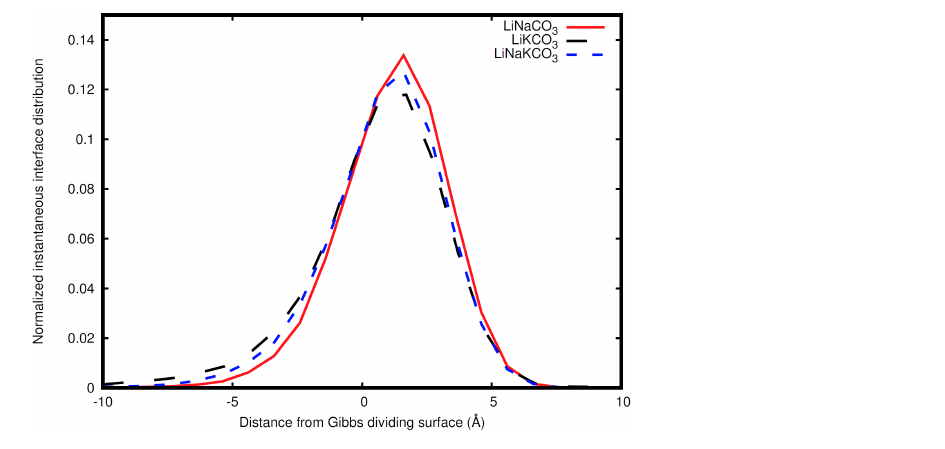
Figure 6 Distribution of instantaneous interface sites relative to the Gibbs dividing surface. LiNaCO 3 (red), LiKCO 3 (black), and LiNaKCO 3 (blue) are shown.